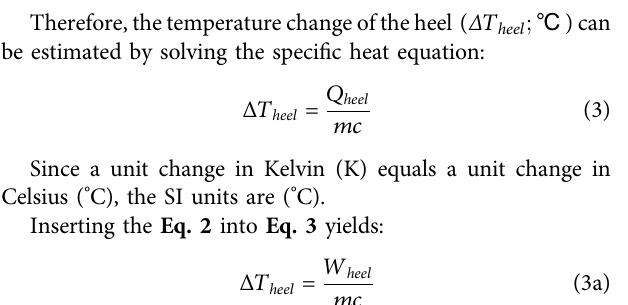
) , skin: 3 . 39 ( kJ (cid:1) 3 . 80 ( kJ (cid:1) kgK bone: 1 . 26 − 1 . 30 ( kJ (cid:1) kgK ) (Giering et al., 1996; Feldmann et al.,